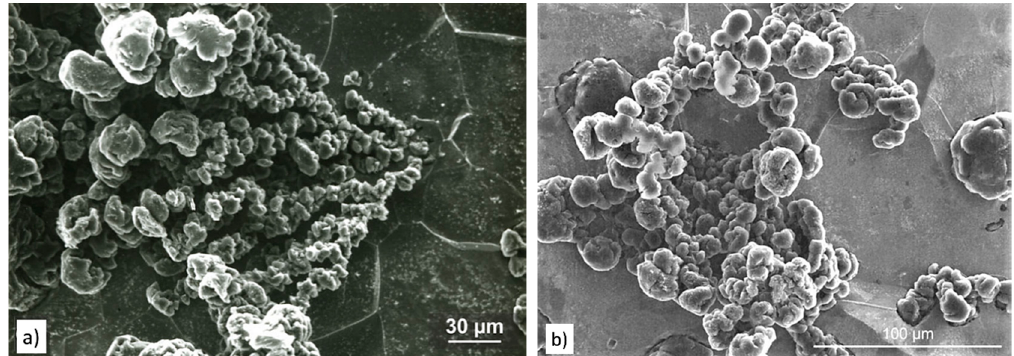
Figure 38. SEM images of chunky graphite: ( a ) Chunky graphite (CHG) growing from a common source in a heavy casting, reproduced from [130,133] with permission from Springer; ( b ) degenerated graphite assembly in Si solution- strengthened high Si SG iron, reproduced from [130,134] with permission from Springer.